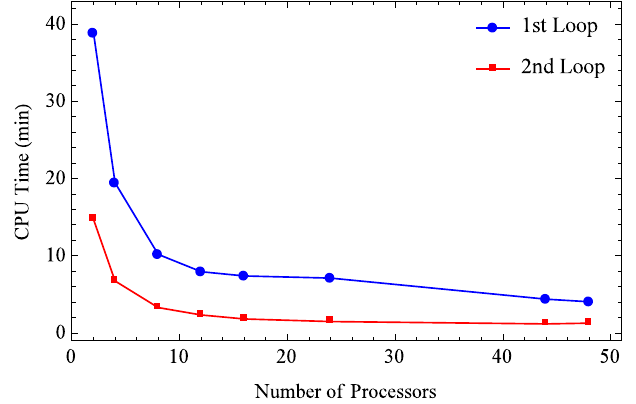
4. Comparison of the computational times of the parallel Simò code when only one of the loops used for force compu- tations is parallelized at a time, showing that it is more efficient to parallelize the second loop.